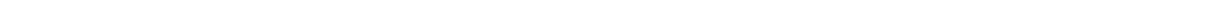
Fig. 1 CEACAM1 is expressed on CD8 + T cells and is essential for resolving LCMV infection. a CEACAM1 expression on naïve CD8 + T cells (left panel) and Tet-GP33 + CD8 + T cells (right panel) from wild-type (WT; black line) or Ceacam1 – / – (red line) mice infected with 2 × 10 4 plaque-forming units (PFU) of LCMV-Docile at indicated time points. Isotype control antibody staining of T cells from WT mice is shown as a gray area ( n = 4 – 6 per group). b Absolute number of Tet-GP33 + and NP396 + CD8 + T cells in blood from WT or Ceacam1 – / – mice after intravenous infection with 200 PFU of LCMV-Docile at indicated time points ( n = 4 – 6 per group). c Absolute number of CD8 + T cells and percentages of Tet-GP33 + CD8 + T cells in spleen, lymph node, liver, lung, kidney, and blood ( n = 6 – 8 per group) from WT or Ceacam1 – / – mice on day 8 after infection with 200 or 2 × 10 4 PFU of LCMV-Docile. d , e Intracellular cytokine interferon- γ (IFN- γ ) secretion in Tet-GP33 + CD8 + T cells ( d ) and median fl uorescence intensity (MFI) levels in IFN- γ + Tet-GP33 + CD8 + T cells ( e ) from splenocytes of WT and Ceacam1 – / – mice on day 8 after infection with 200 or 2 × 10 4 PFU of LCMV-Docile. Horizontal dotted lines designate the detection limit without restimulation ( n = 6 – 8 per group). f Ratio of the percentage of IFN- γ + cells to the percentage of Tet-GP33 + CD8 + T cells from WT and Ceacam1 – / – mice on day 8 after infection with 200 ( n = 12) or 2 × 10 4 ( n = 7) PFU of LCMV-Docile. g Viral titers from WT and Ceacam1 – / – mice in indicated organs and serum 8 days after intravenous infection with 200 or 2 × 10 4 PFU of LVMC-Docile ( n = 6 – 8 per group). * P < 0.05; ** P < 0.01; *** P < 0.001; and **** P < 0.0001 (Student ’ s t test). ns = not signi fi cant. Data are representative of two ( a , c , d , e , f , g ) or three ( b ) experiments (mean ± SEM; b , c , d , e , f , g